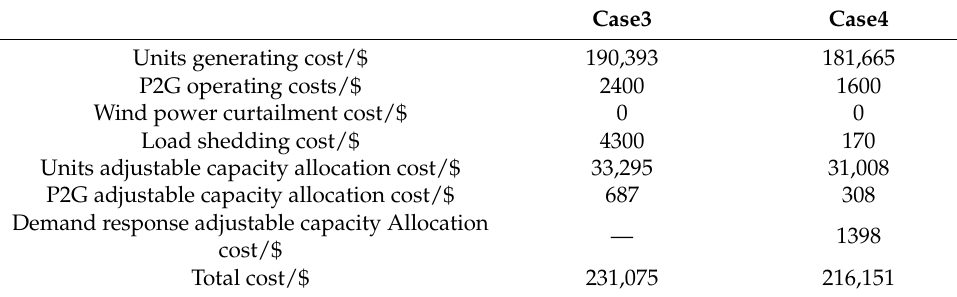
Table 2. Dispatch results of power system in two